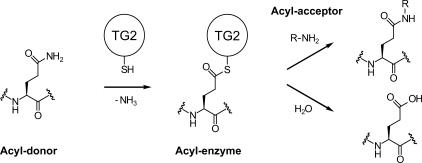
Reactions Catalyzed by TG2TG2 can catalyze the transamidation of Gln to a suitable amine or the deamidation of Gln to Glu.